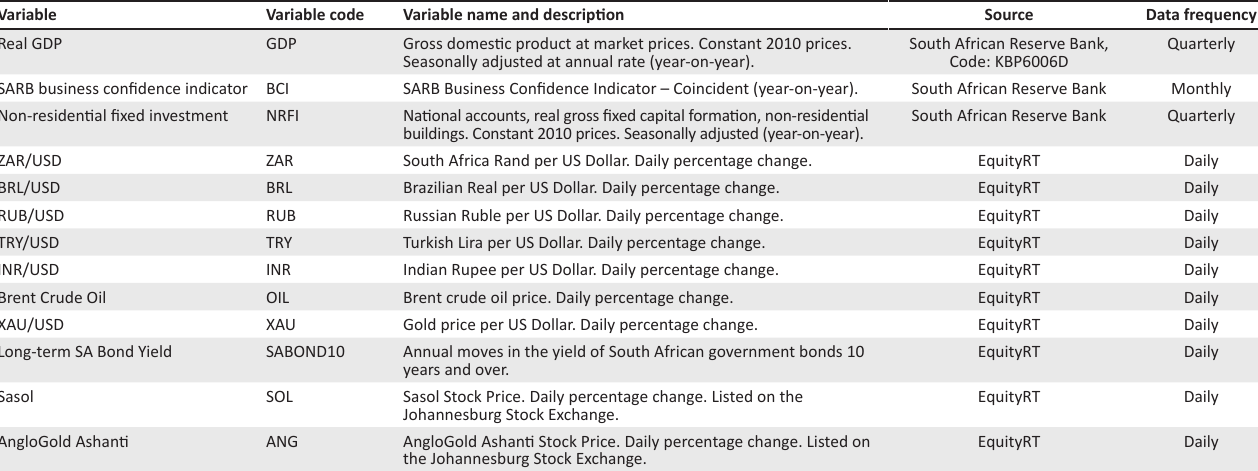
TABLE 1: Description of the South African variables used in the study.